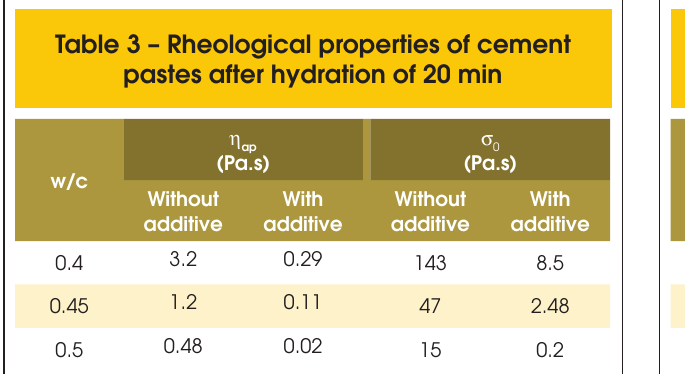
Table 4 – Rheological properties of